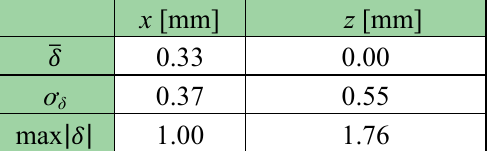
Table 4. Precision parameters of the coordinates of characteristical